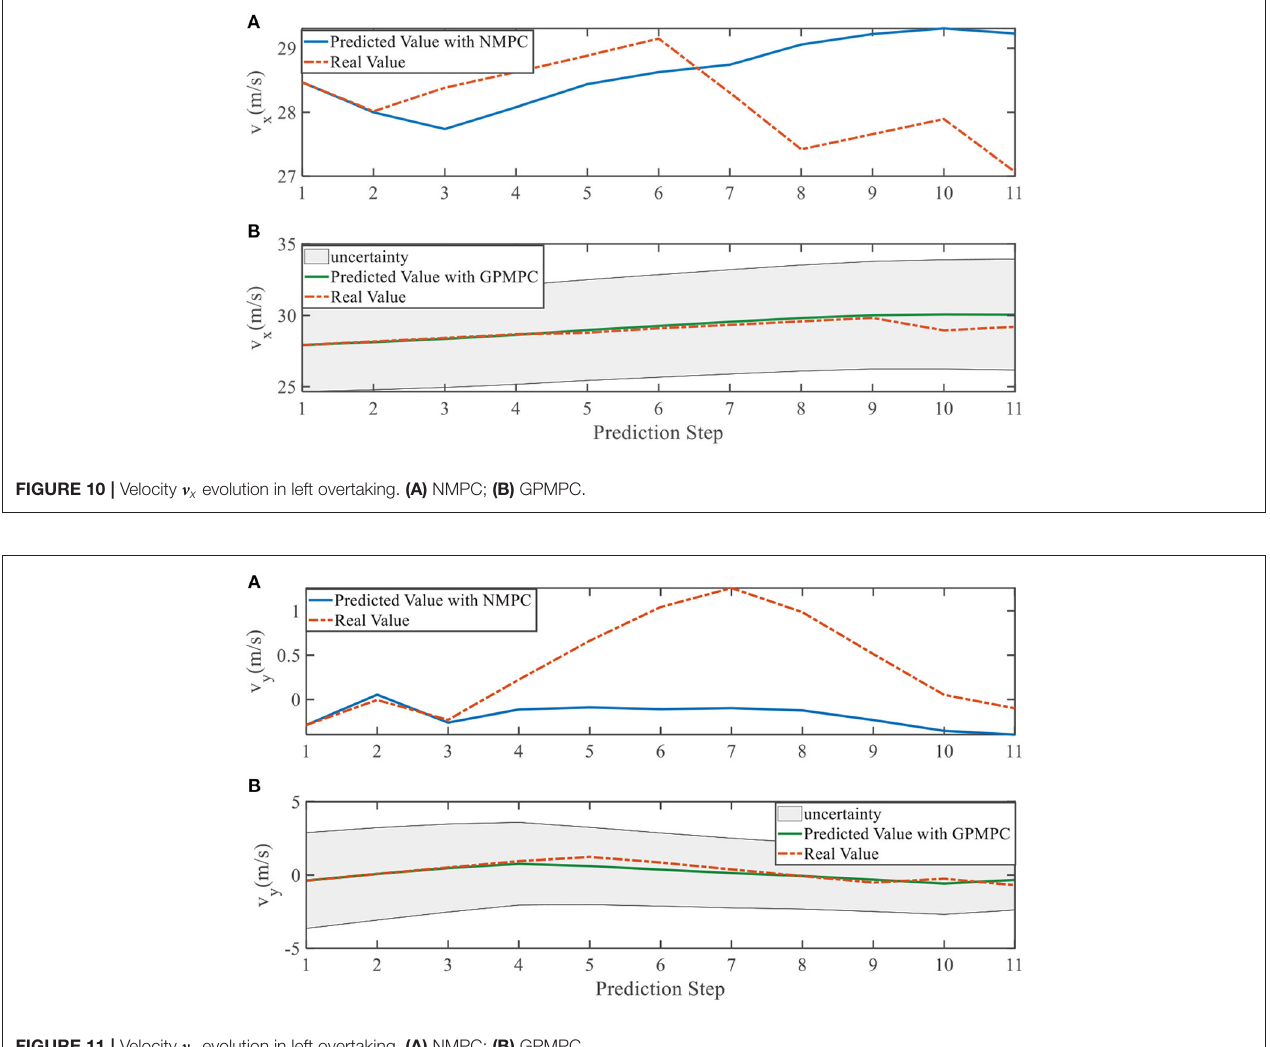
FIGURE 11 | Velocity v y evolution in left overtaking. (A) NMPC; (B) GPMPC.